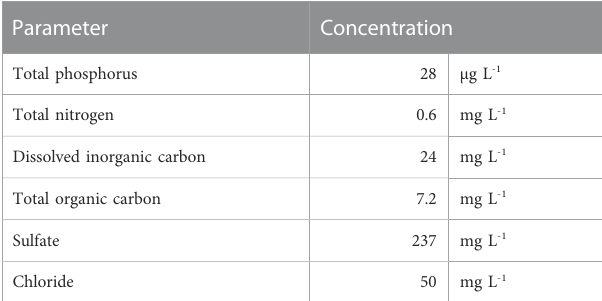
TABLE 1 Selected quality parameters of Lake Müggelsee water (03.06.2021) used for the